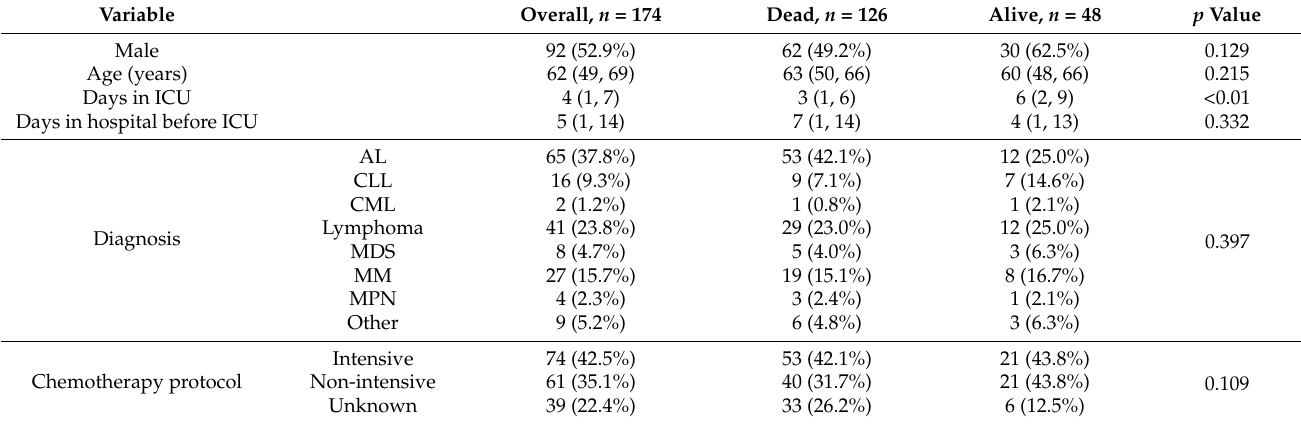
Table 2. General characteristics of the cohort. ICU = intensive care unit; MM = multiple myeloma; AL = acute leukemia, CLL = chronic lymphocytic leukemia; MDS = myelodysplastic syndrome; MPN = myeloproliferative neoplasm; CML = chronic myelogenous leukemia. The values in brackets represent percentages and